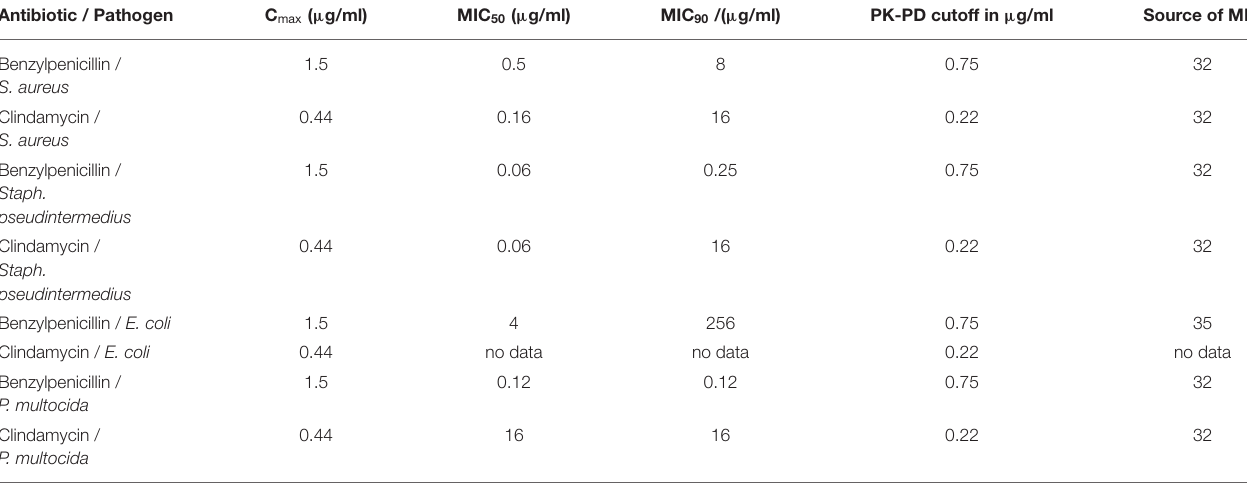
TABLE 13 | Approved and recommended doses of antibacterial substances for empirical treatment of CNS infections and peripheral infections in dogs (for comparisons of doses used in PK studies see Tables 4 , 5 ). Active Substance Approved dose for various peripheral infections (trade Dose recommended for the treatment of CNS name given as example) infections (example of